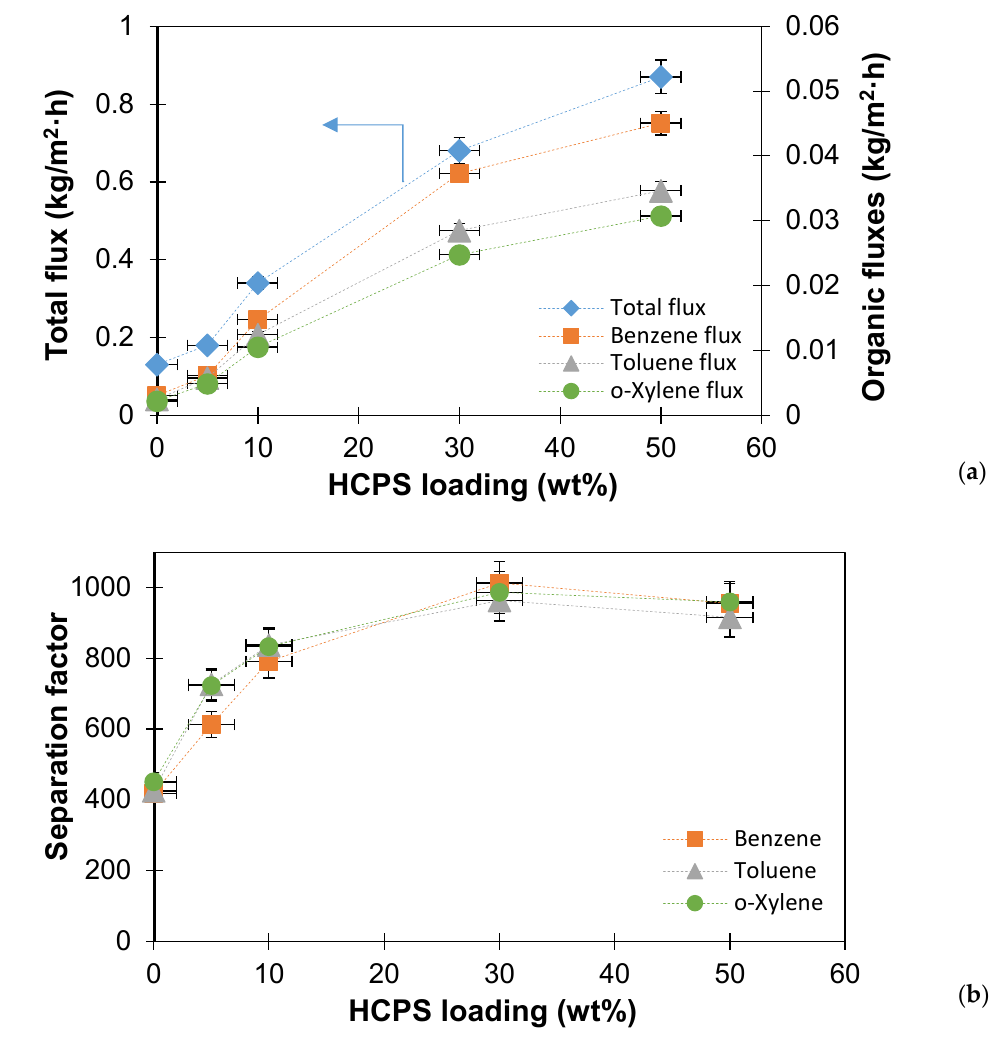
Figure 7. The dependence of the permeate flux, the flux of organic components ( a ) and the separation factor ( b ) on the HCPS loading into PTMSP during the pervaporation separation of a multicomponent BTX mixture.